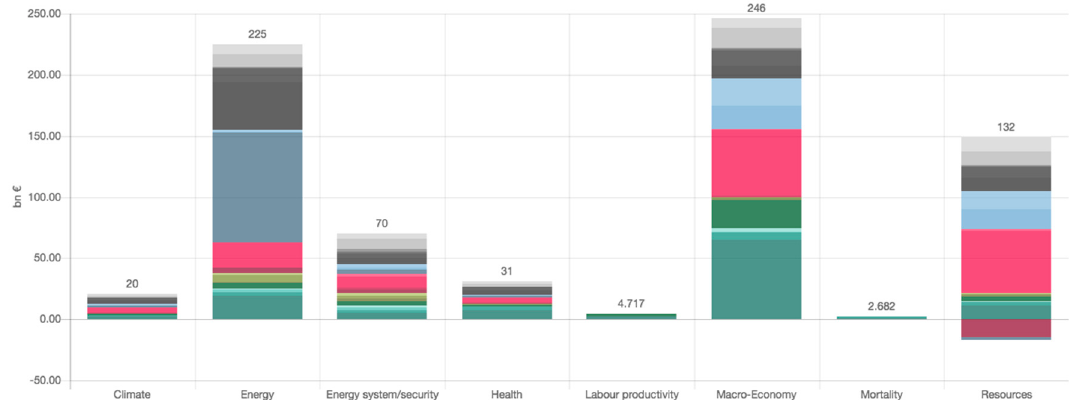
Figure 1. Monetised impacts in bn €/y in 2030 (for colour legend see [72]).